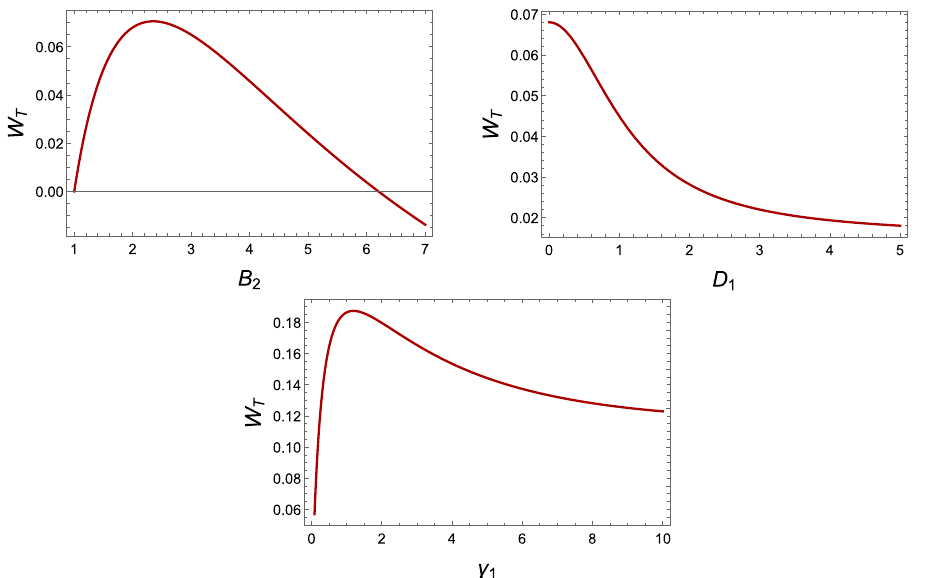
Figure 1. Plots of the total work for an Otto cycle operating between T 1 = 1 and T 2 = 4 using the steady state. (Top left): We fix J = 1 , D 1 = 0 , D 2 = 5 , γ 1 = 0.1 , γ 2 = 5 , ¯ n b = 0 and vary the magnetic field from B 1 = 1 to B 2 reported on the horizontal axis. (Top right): We fix J = 1 , γ 1 = 0.1 , γ 2 = 5 , D 2 = 5 , B 1 = 1 and B 2 = 2 ; and vary the D 1 from 0 to 5. (Bottom): We fix J = 1 , B 1 = 1 , B 2 = 2 , D 1 = 0 , D 2 =5, γ 2 = 5 , n b = 0 and we change interaction rate of first qubit with its surrounding ( γ 1 ) from 0 to the value reported on the horizontal axis.